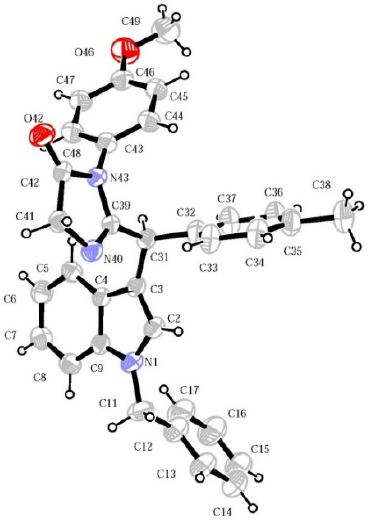
Figure 1. Crystal structure of imidazolone 3d .